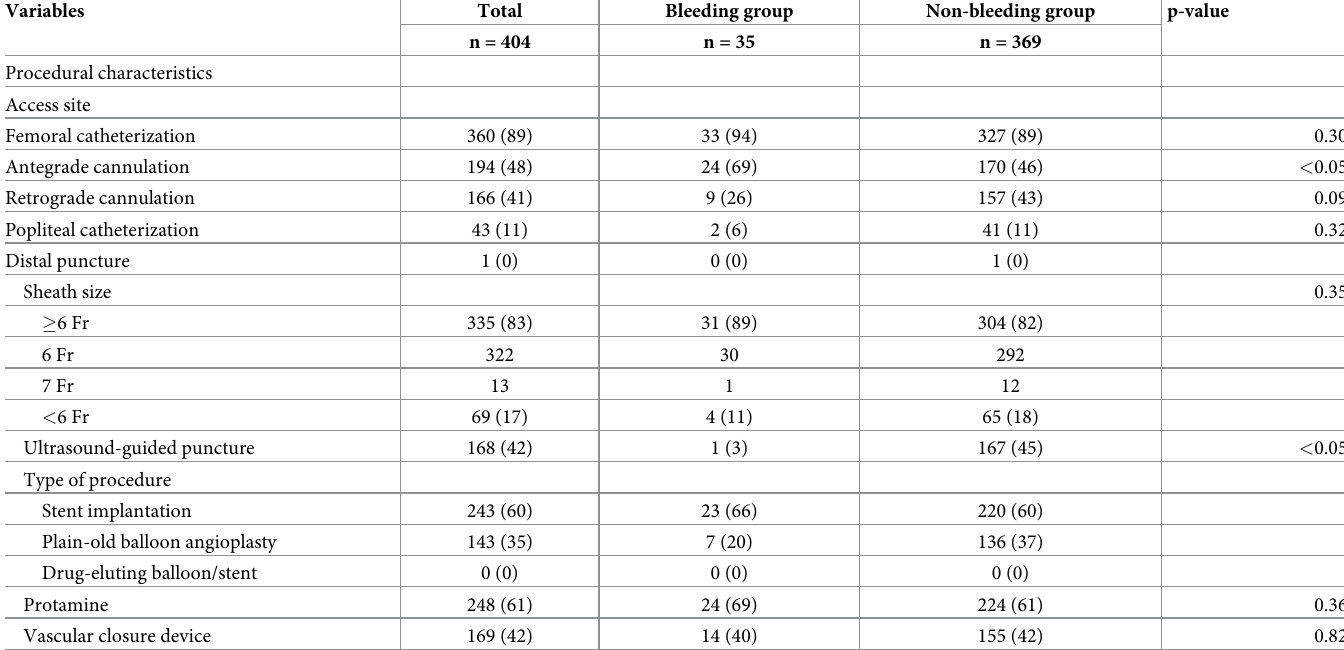
Table 2. Procedural characteristics a .